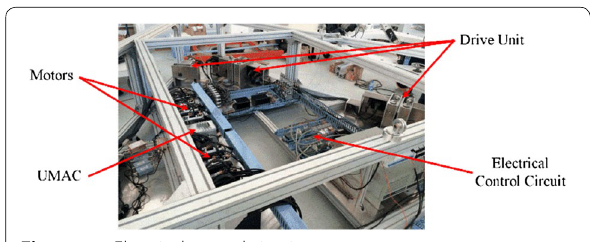
Figure 11 Electrical control